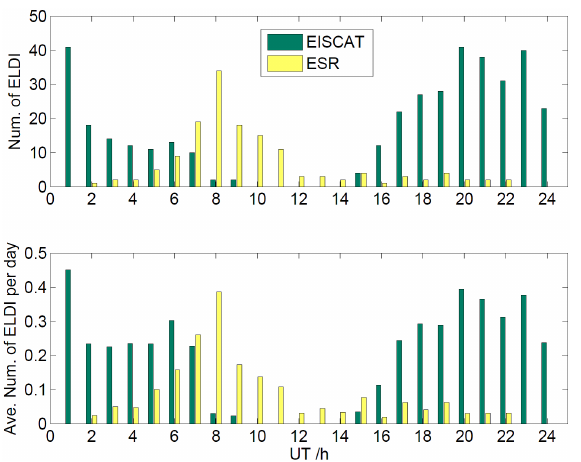
Figure 8. Ionization rate caused by incident monoenergy auroral electrons in polar upper atmosphere (from Cai and Ma, 2007). 525